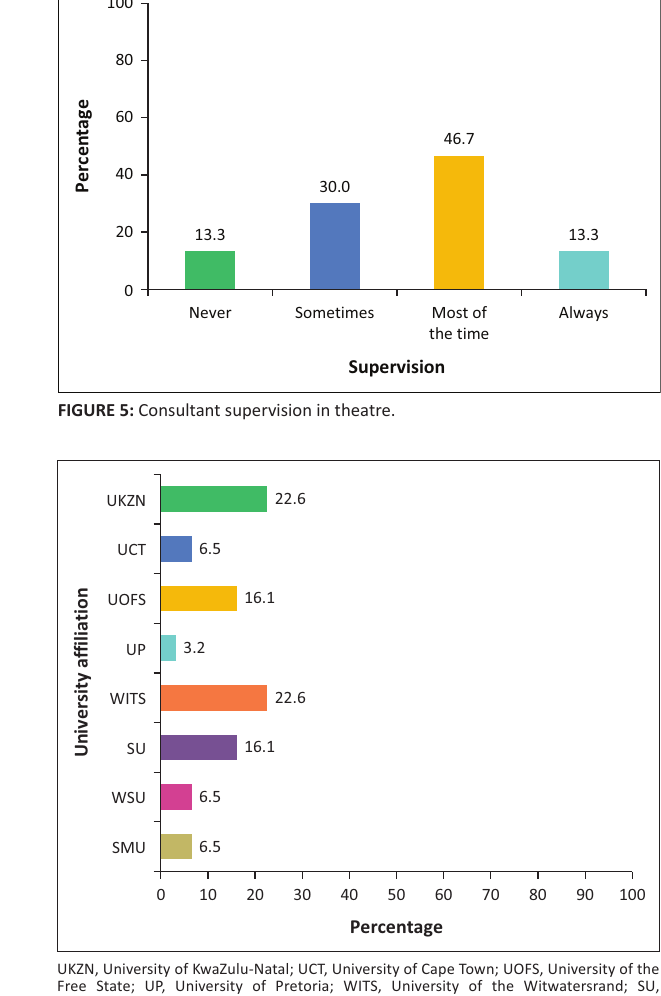
FIGURE 4: Hours spent in theatre per week.